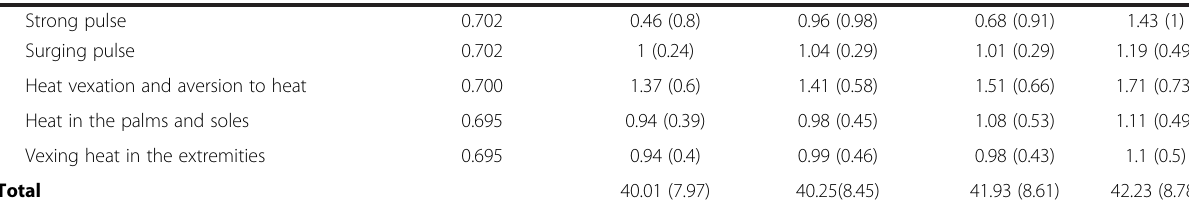
Table 2 Internal consistency (Cronbach ’ s coefficient α ) total and within each pattern and mean scores for each item of patterns (Continued)